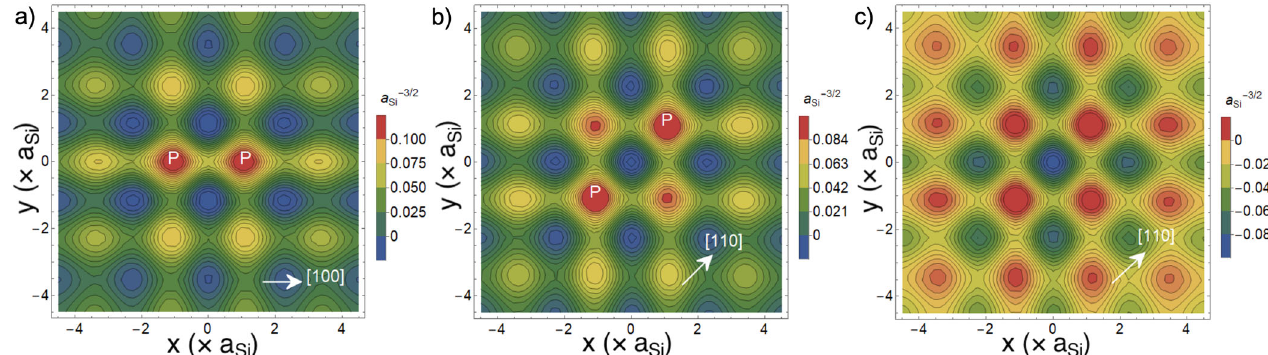
Fig. 1 Spatial dependence of the variational 2P wave function amplitude in the effective mass approximation. The length scale is the lattice constant of Si ( a Si ), with Bloch function u ( r ) = 1. a The principal maxima are at the two donors' positions: ( − 1, 0) and (1, 0) in the x – y plane, with secondary maximum due to short-range traveling waves at ( − 1, − 2), (1, 2) and so on. The overall diminishing amplitude away from the donors is determined by the envelope function. Here the 2 P multi-donor quantum dot is oriented along [100]. b Two donors' positions: ( − 1, − 1) and (1, 1) in the x - y plane, with secondary maximum at ( − 1, 1),(1, − 1) and so on. The 2 P multi-donor quantum dot is oriented along [110]. c In-plane amplitude variation of 2 P ∥ [111] with two donors' positions: ( − 1, − 1, − 1) and (1, 1, 1). à Only diminished secondary maximum in x – y plane are